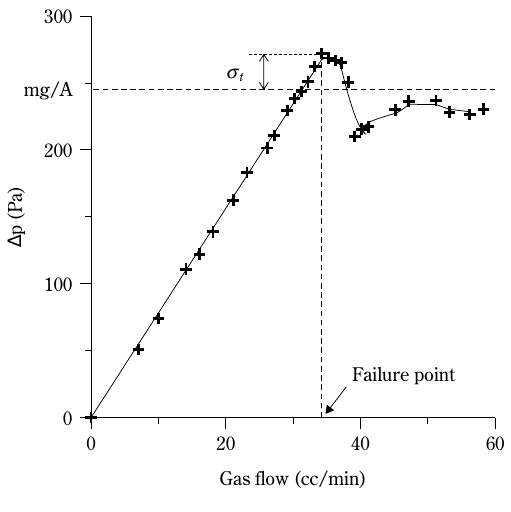
Original apparatus used by us for measuring the uniaxial tensile yield stress of the powder.